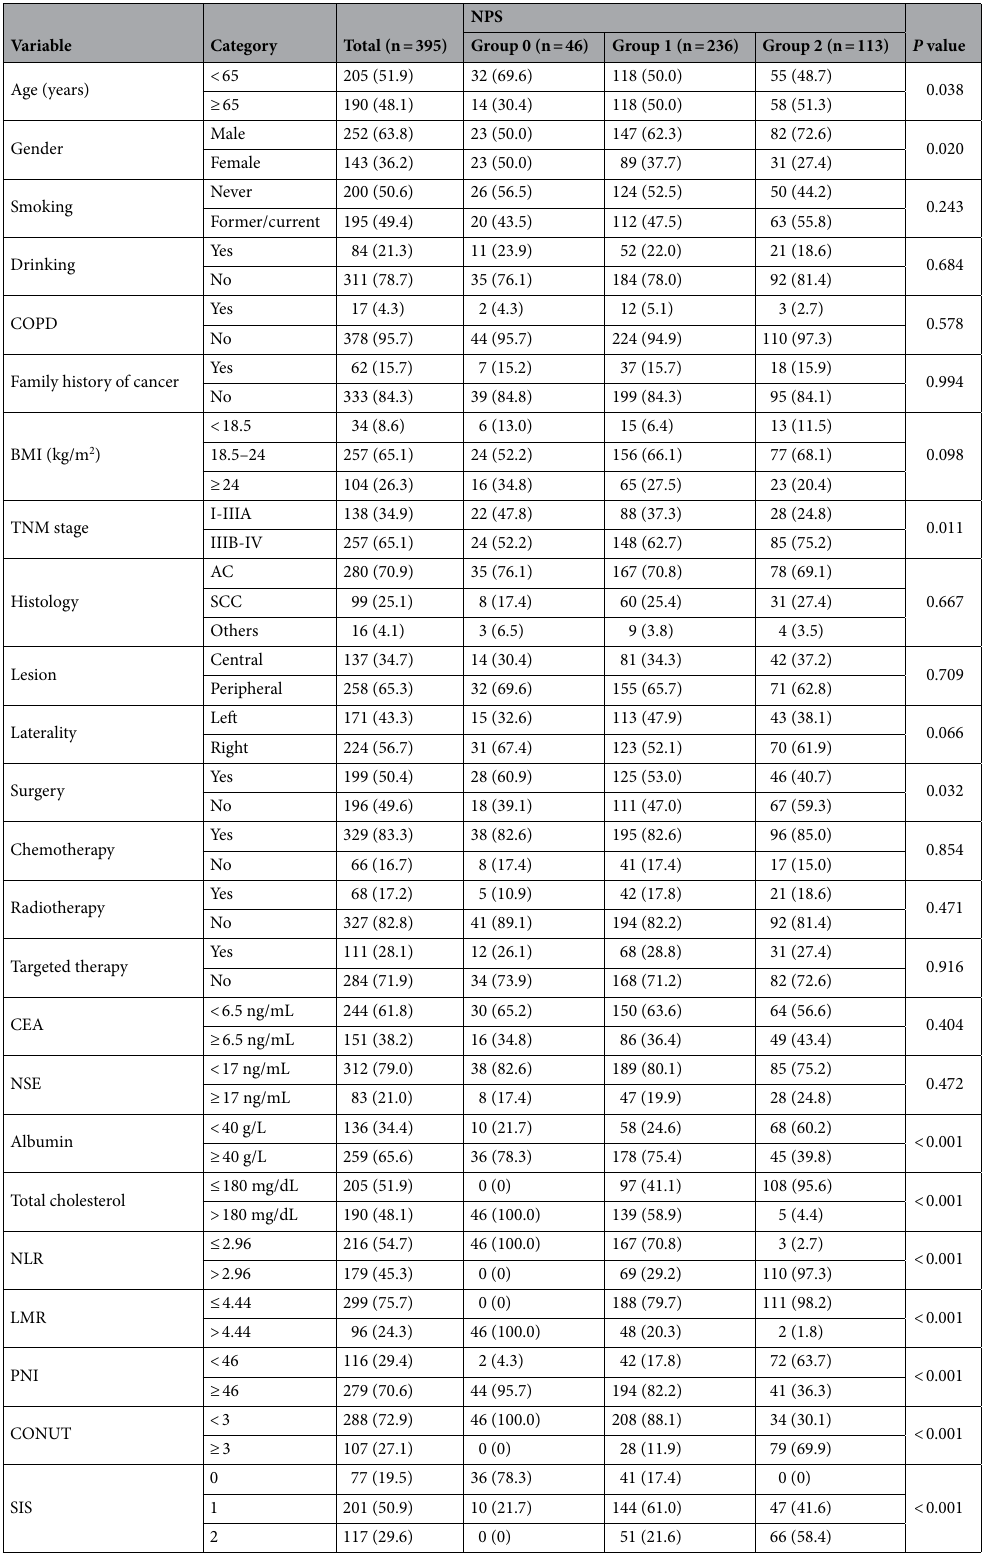
Table 2. The relationship between NPS and clinical characteristics in NSCLC patients. AC adenocarcinoma, BMI body mass index, CEA carcinoembryonic antigen, CONUT controlling nutritional status, COPD chronic obstructive pulmonary emphysema, LMR lymphocyte-to-monocyte ratio, NLR neutrophil-to-lymphocyte ratio, NPS Naples prognostic score, NSE neuron-specific enolase, PNI prognostic nutritional index, SCC squamous cell carcinoma, SIS system inflammation score. Values are n